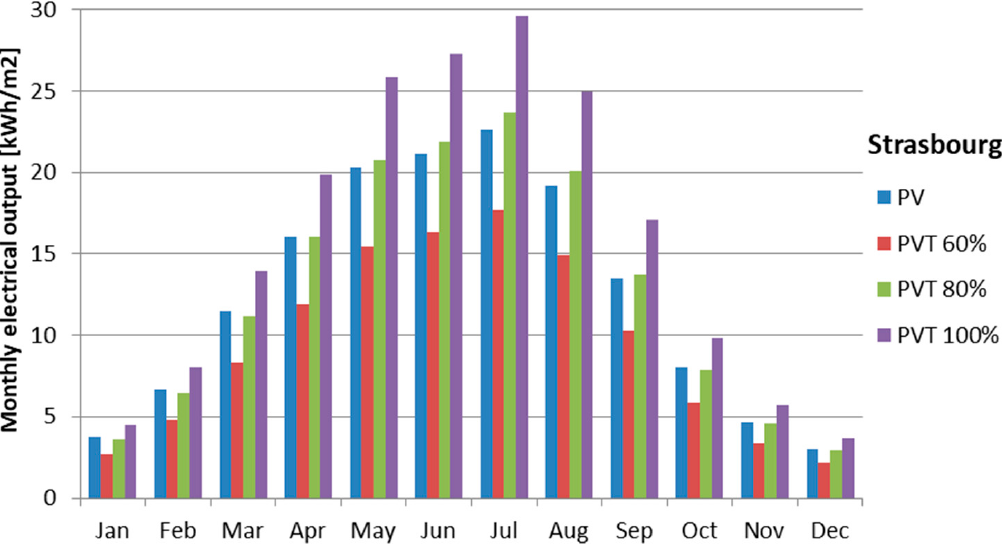
Figure 13. Monthly electrical output of the PV panel and PVT collector with different packing factors in Strasbourg, France.